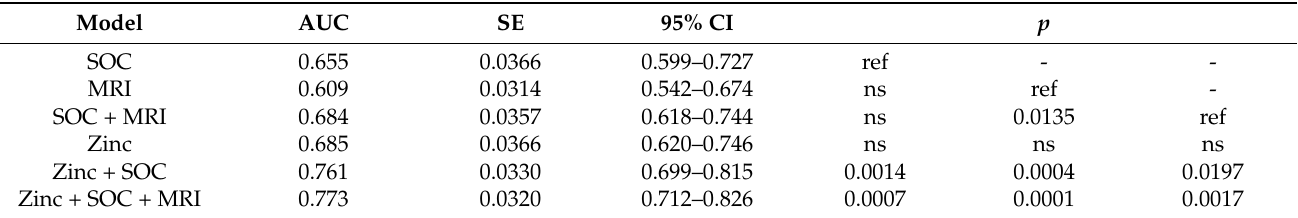
Table 8. Diagnostic performance in MRI